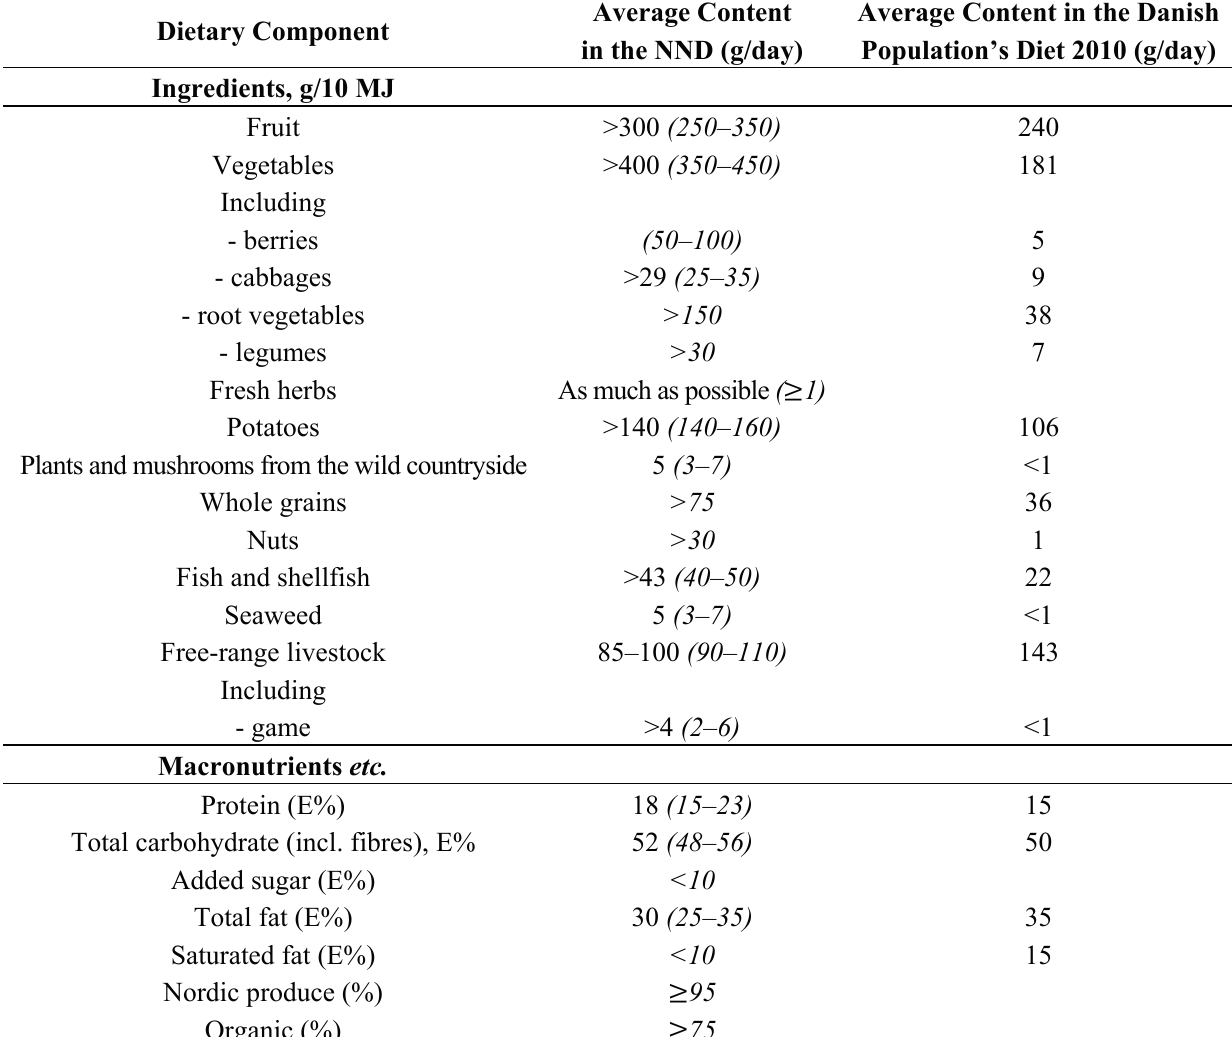
Table S1. Overview of the average daily content of the dietary components in the New Nordic Diet (NND) in relation to the average daily content in the Average Danish